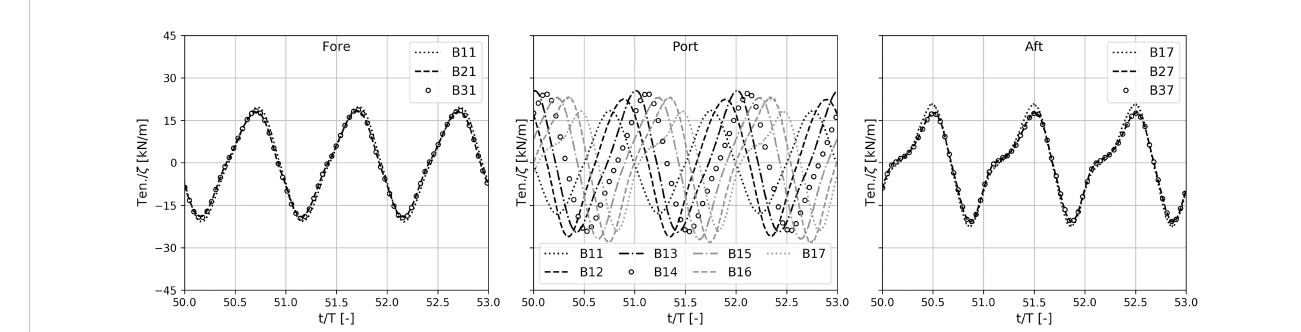
FIGURE 11 Time series of computed tension acting in the moorings at fore, port and aft in a regular wave of w = 0.33 rad/s.